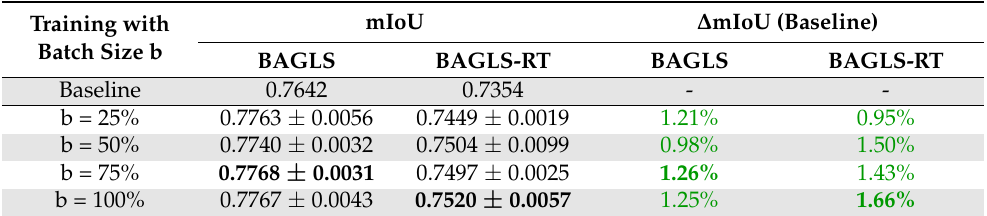
Table 1. Segmentation performance of the U-Net after re-training from scratch on the corresponding test data of BAGLS and BAGLS-RT.